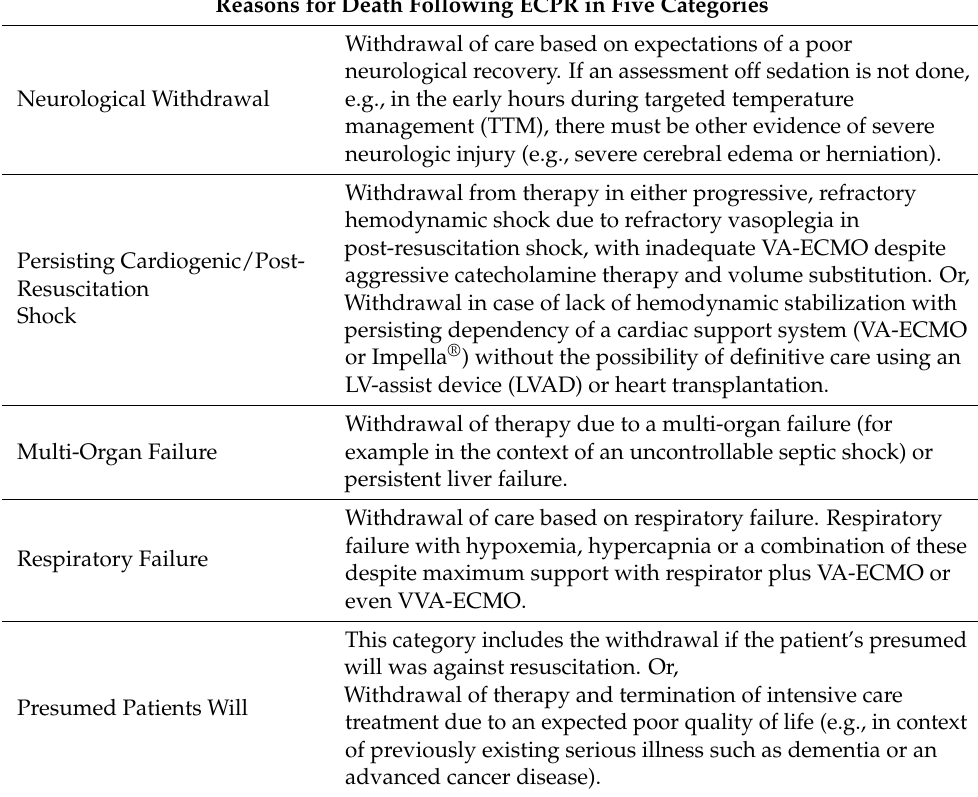
Table 1. Categorization of the mode of death in extracorporeal cardiopulmonary resuscitation (ECPR) patients. Adaptation of reasons for death following ECPR of the categories adopted from Witten et al.